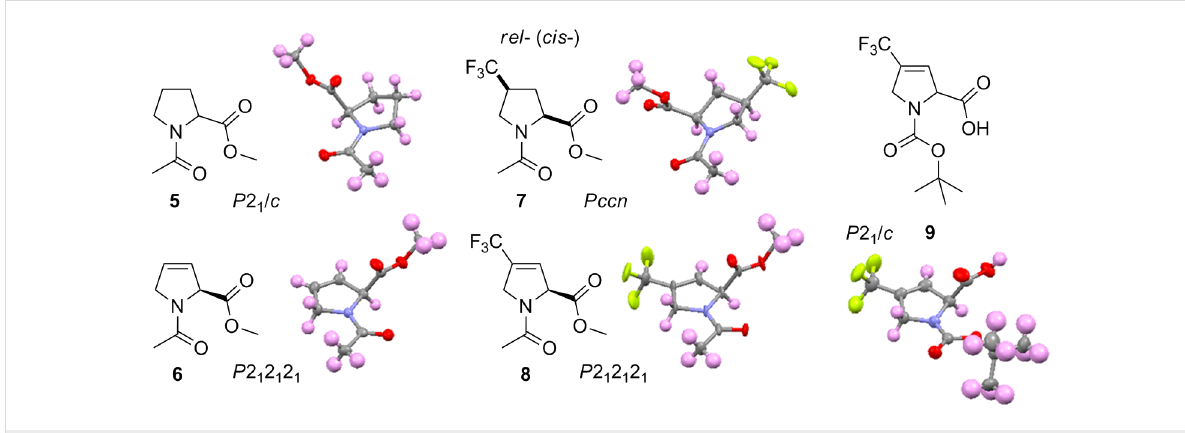
Figure 2: X-ray crystal structures of compounds 5 – 9 . Carbon- grey, nitrogen – blue, oxygen – red, fluorine – yellow, hydrogen – purple.